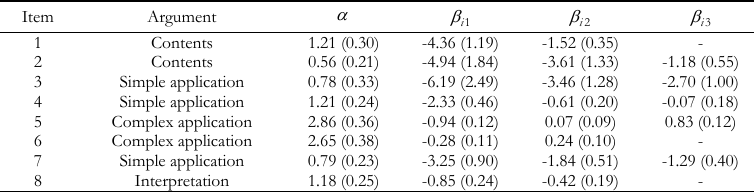
Item parameter estimates for the 1st test (standard errors in